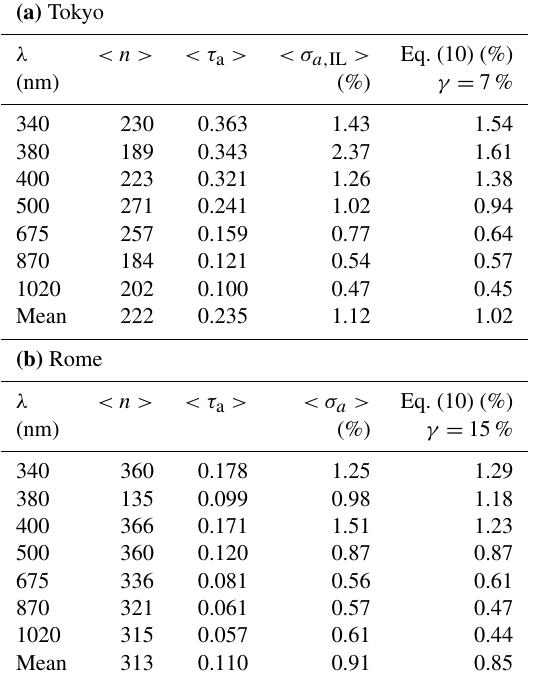
Table 3. (a) Monthly mean values of n , τ a , and σ a, IL obtained by ILP at the Tokyo University of Science (TUS) site averaged for the period of February–May 2017 and (b) those at the Roman site av- eraged for October 2017 and May–September 2019, other than the 380nm data, which were taken only in October 2017. Estimates of σ a, IL are also given by Eq. (10) assuming γ value of 7% for Tokyo and 15% for Rome. All wavelength means are shown in the bottom of each table.